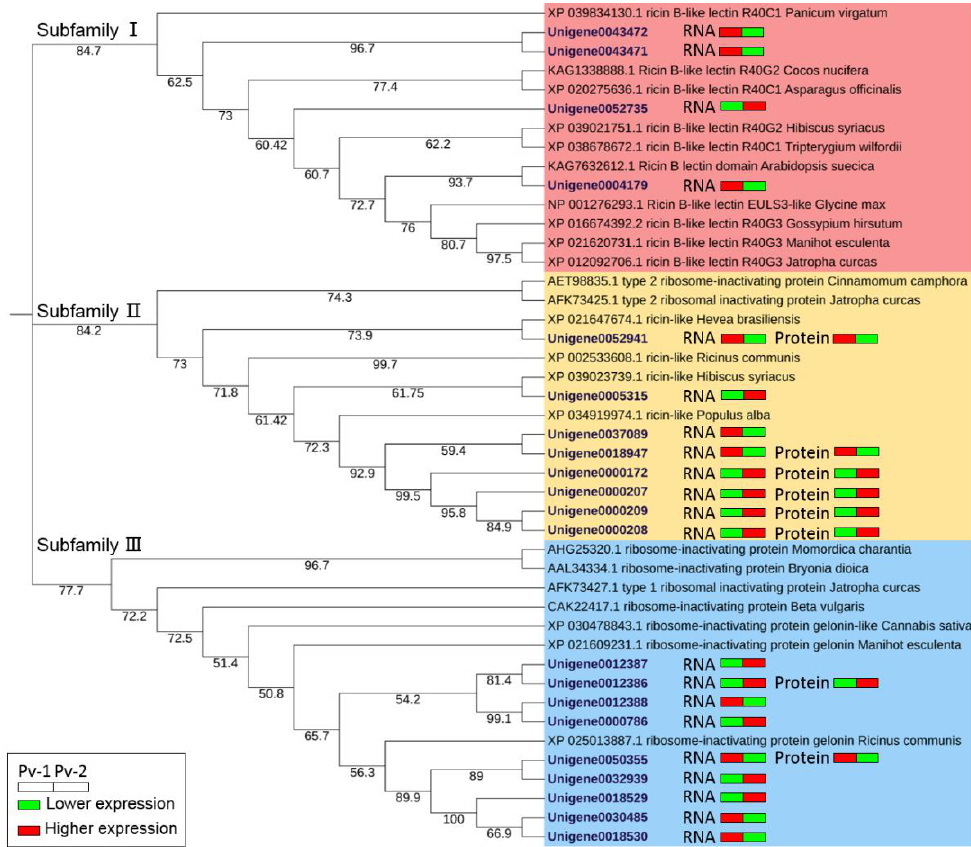
Figure 4. ML phylogenetic tree of 21 RIPs in P. volubilis and 23 RIPs in other plants with 1000 boot- strap replicates. The number below the branches indicates bootstrap percentages. The icons right to each RIP ID showed the expression patterns of each transcript/protein through the two seed devel- opmental stages, with the green color indicating lower expression/abundance, while the red color indicates higher expression/abundance.